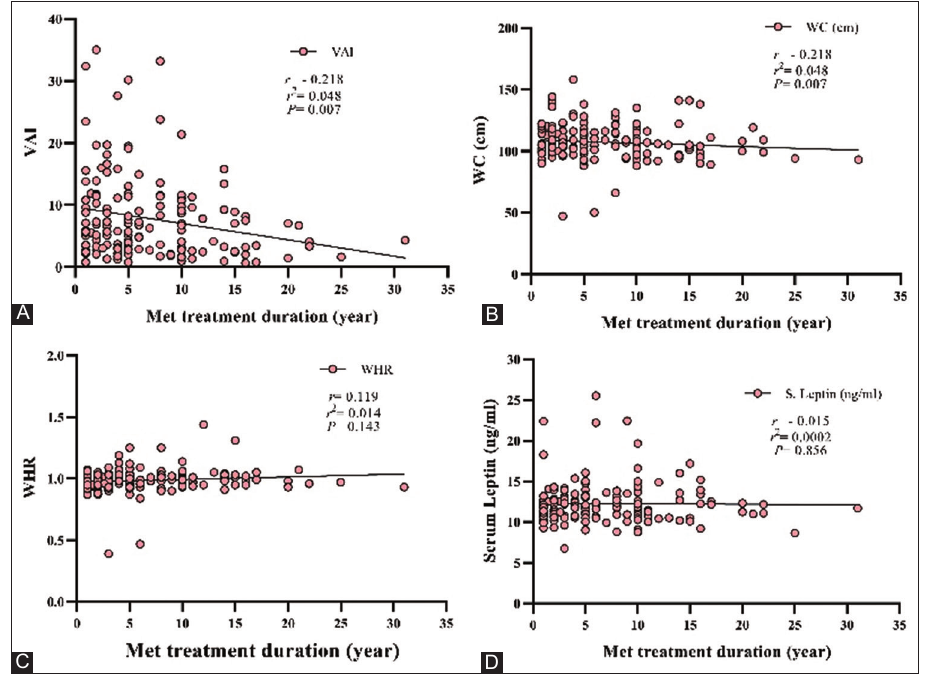
FIGURE 4. Correlation of metformin treatment duration with (A) VAI, (B) WC, (C) WHR, and serum leptin levels (D) of Iraqi patients with T2DM VAI: Visceral adiposity index; WC: Waist circumference; WHR: Waist to hip ratio; r : Pearson’s correlation coefficient.